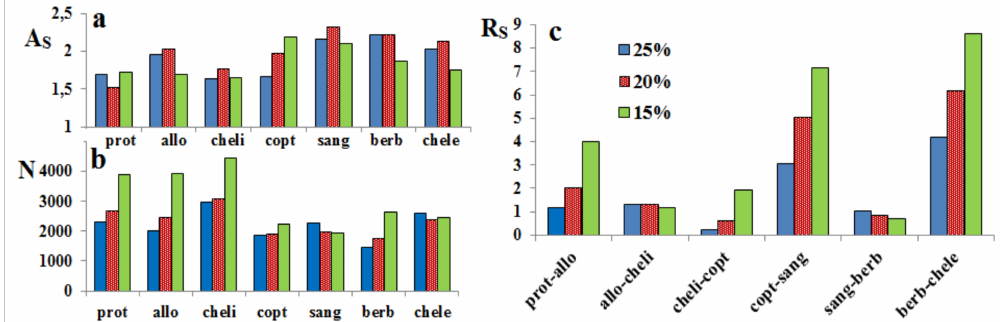
Figure 3. Relationship between the concentration of acetonitrile in the mobile phase and: ( a ) asymmetry (A s ), ( b )the e ffi ciency of the chromatographic system (N), and ( c )—the resolution of neighboring peaks on the chromatogram (R s ).